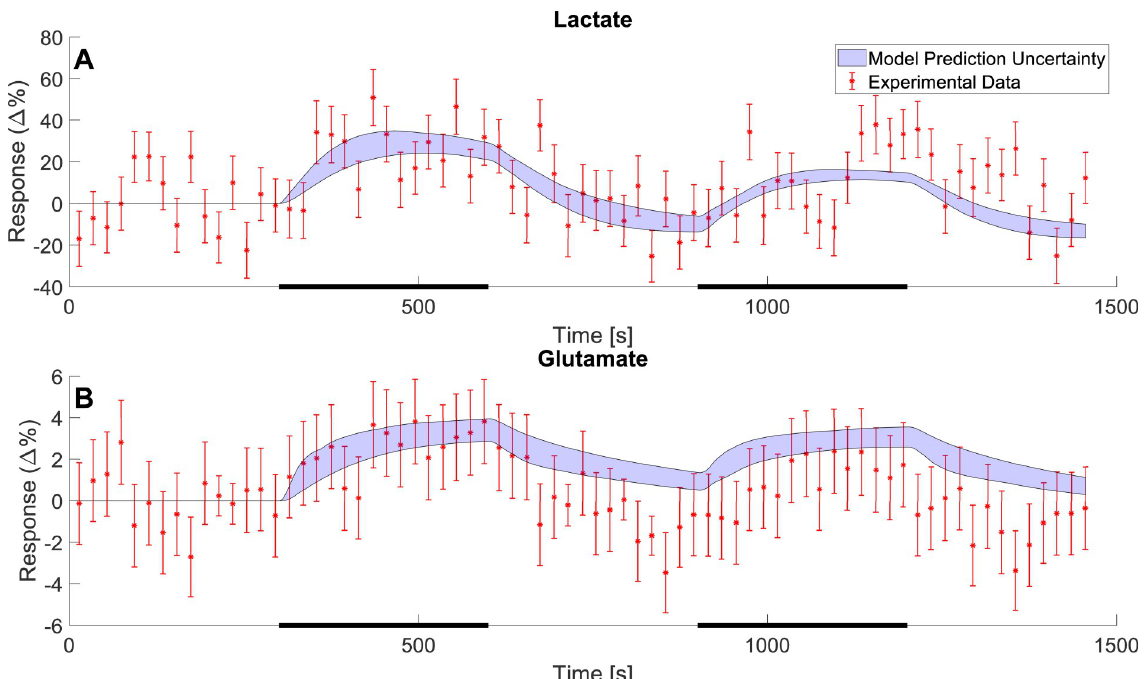
Fig 4. Model predictions of independent MRS data for lactate and glutamate. The model predictions (blue shaded areas) of the changes in metabolic concentrations for lactate (A) and glutamate (B) as a response to a double stimulation paradigm. The stimulation consisted of two 5-minute periods of stimulation (black bars) interwoven by a 5-minute rest period. The data is illustrated as mean values ± SEM (red error bars) and was gathered from Schaller et al. 2013 [36].